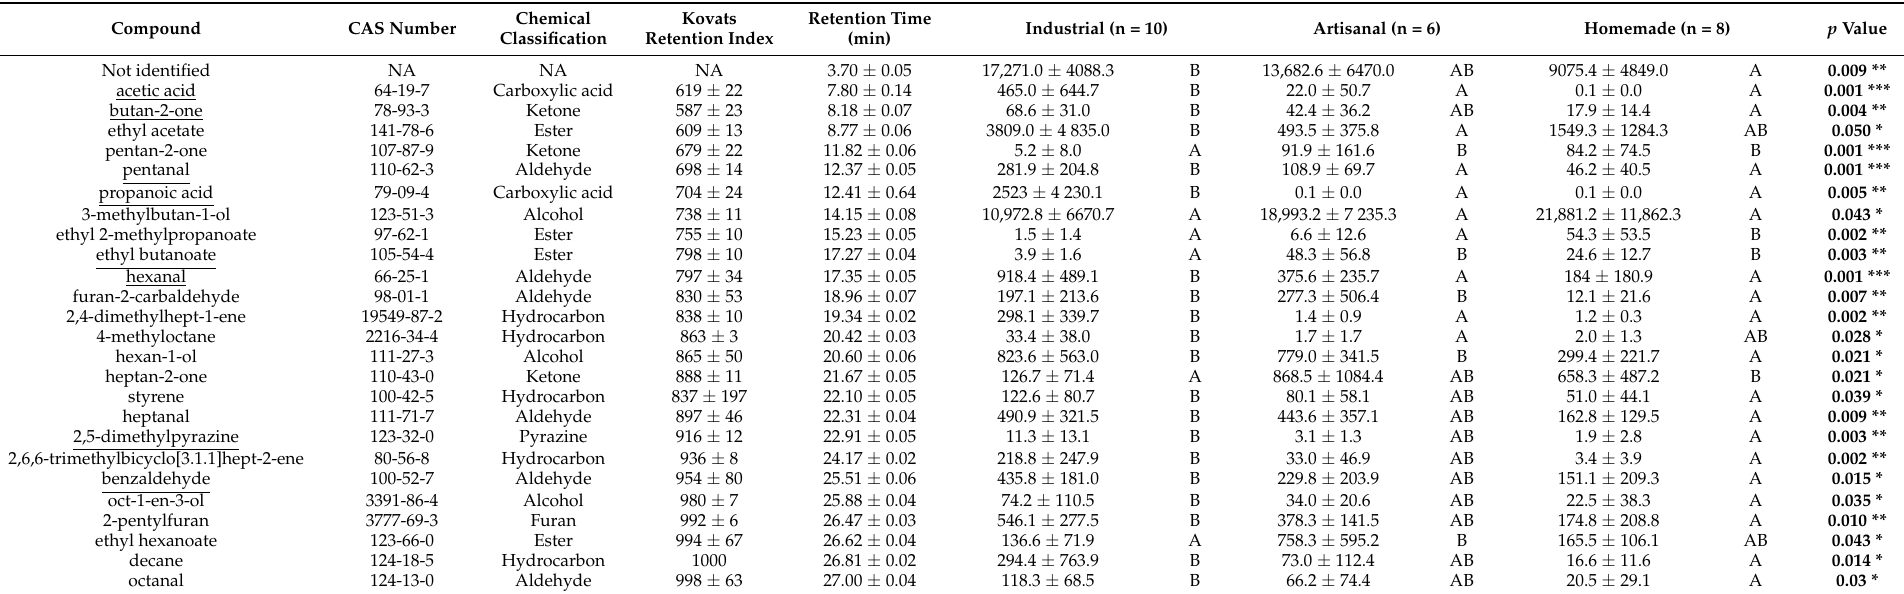
Table 4. Areas under the curve of the intensity–retention time plot ((mean ± standard deviation) × 10 3 ) for the 46 volatile molecules that demonstrated significant differences among processing methods. Compounds are displayed by their IUPAC (International Union of Pure and Applied Chemistry) names and chemical classifications. Kovats retention indexes were taken from PubChem and consolidated with data from the National Institute of Standards and Technology database for a semi-standard non-polar column. n is the total number of soft breads sampled. Molecules that are underlined were treated by EIC; all others were treated by TIC. Mean values ± standard deviation are shown for each method, with the p value of an ANOVA or Kruskal–Wallis test. Statistical groups determined by post hoc test (Tukey or Conover-Iman, respectively) are indicated by letters. * for p ≤ 0.05, ** for p ≤ 0.01, and *** for p ≤ 0.001, in bold when below the threshold of 0.05. NA: not